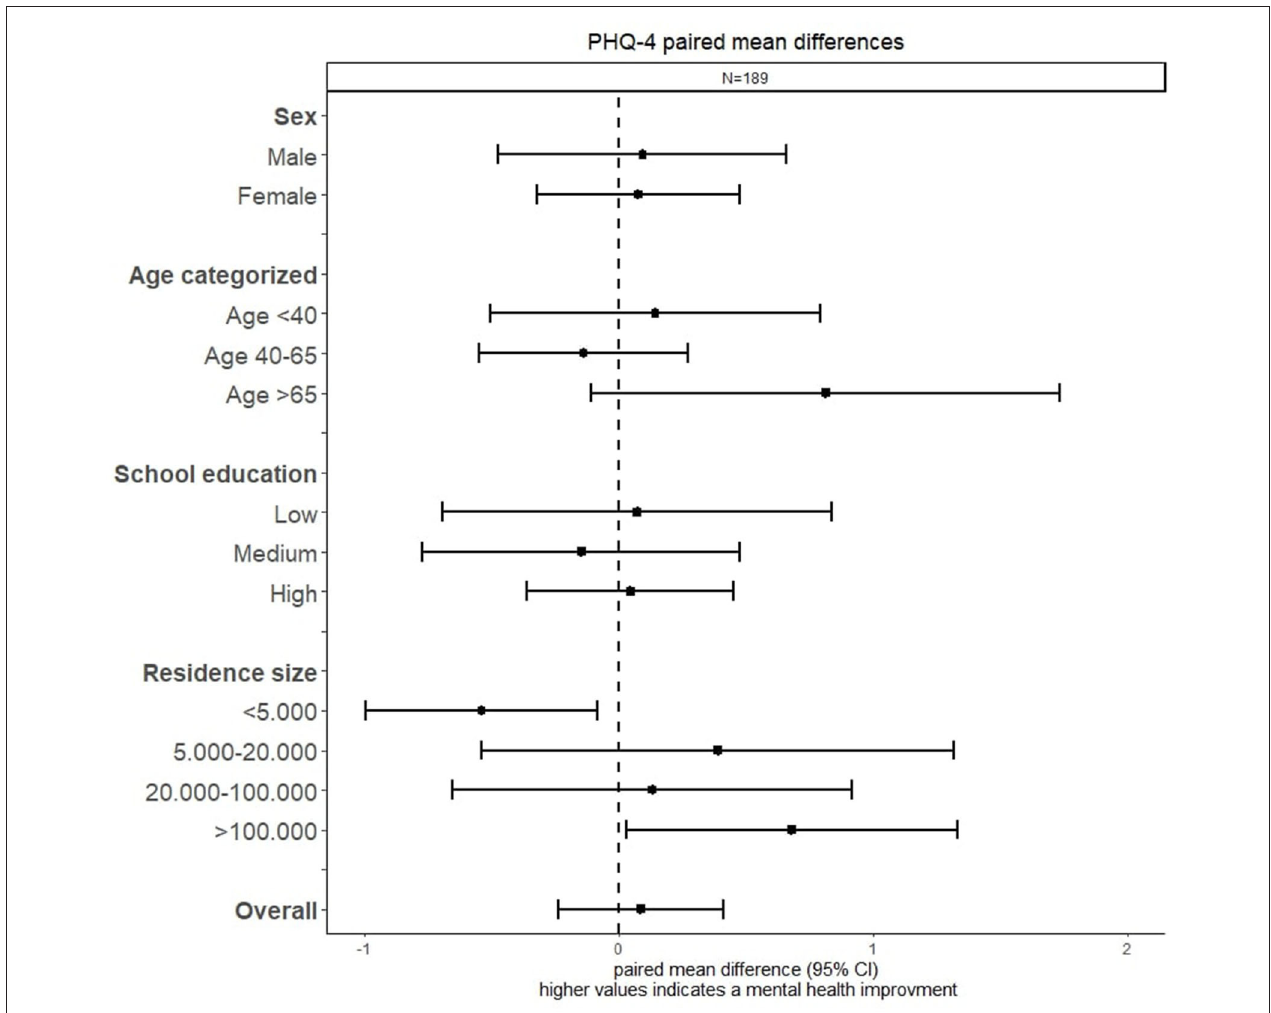
FIGURE 3 | Forest plot of the PHQ-4 paired mean difference across sociodemographic factors.